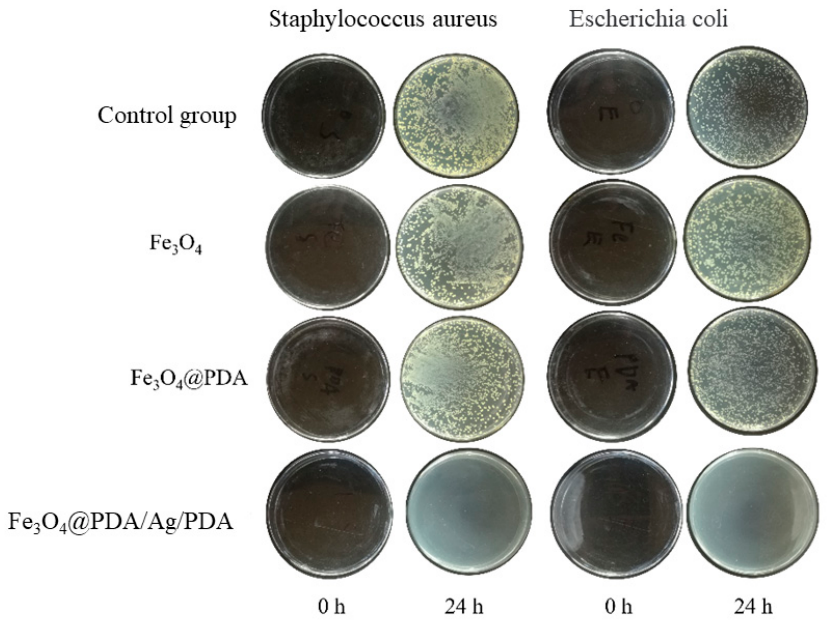
Figure 9. Growth pictures of colonies after adding different samples for 24 h.